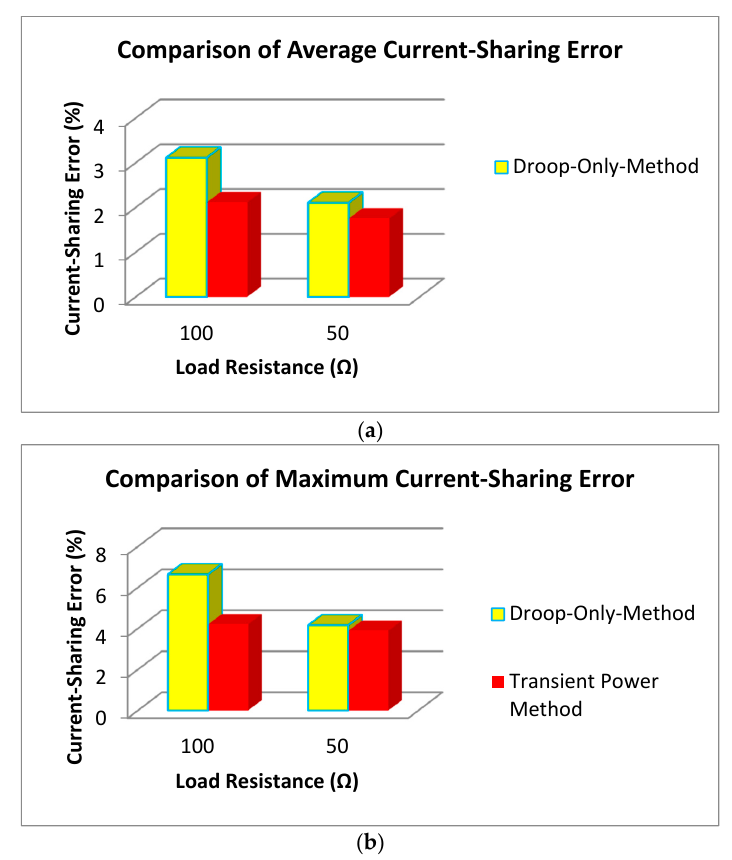
Figure 7. Comparison of average and maximum current-sharing errors by using droop-only-method and TPM. ( a ) Average current-sharing error. ( b ) Maximum current-sharing